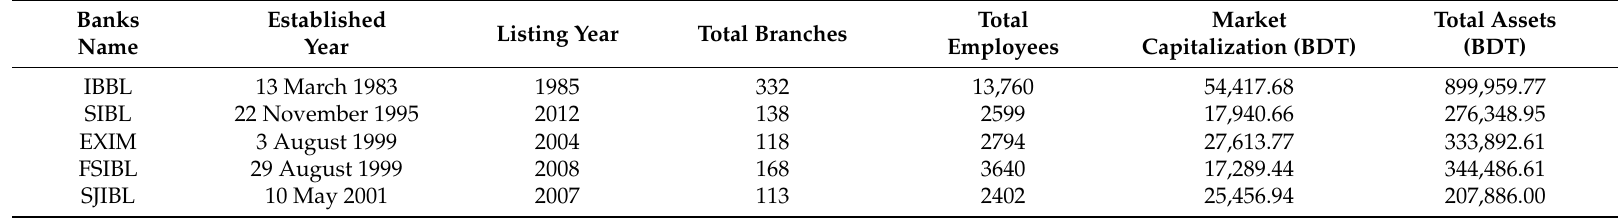
Table A1. List of sample banks for 2017 (amount in Million BDT).